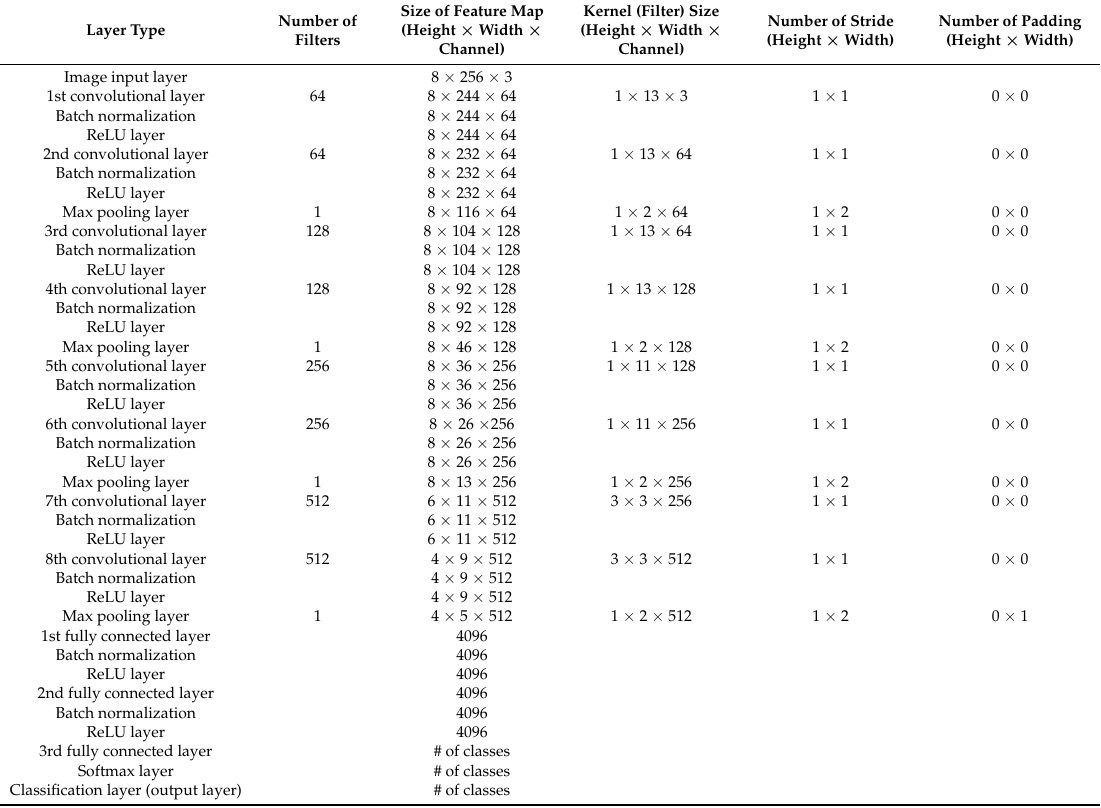
Table 2. The proposed CNN architecture used in our research (ReLU means rectified linear